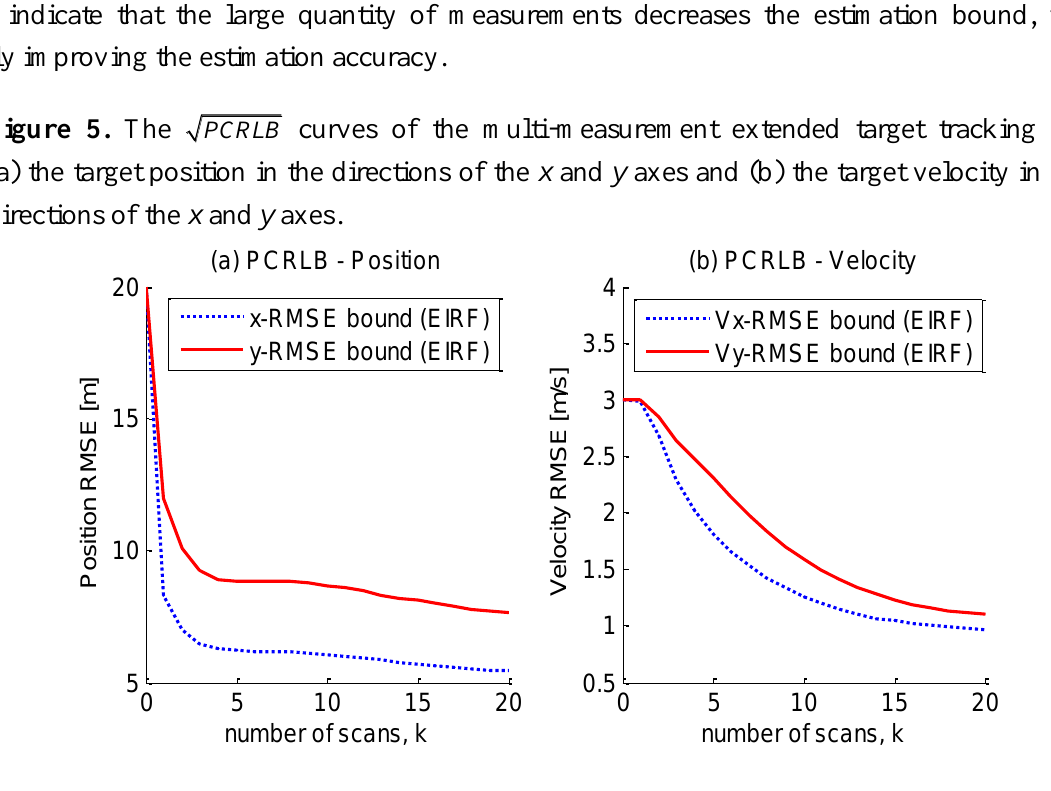
Figure 6. The PCRLB of the multi-measurement extended target tracking for different mean numbers of measurements for (a) the target position in the direction of the x axis. (b) and the target velocity in the direction of the x